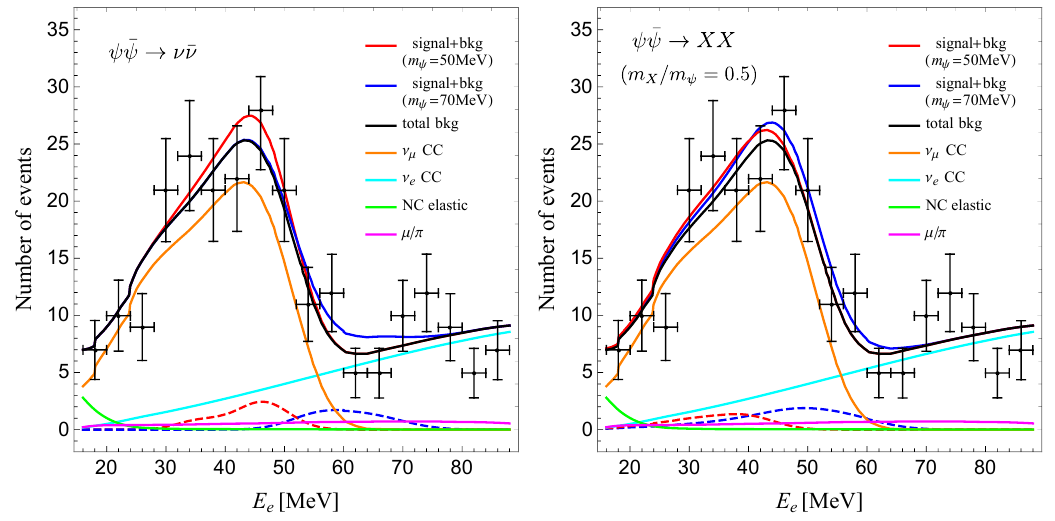
Figure 4 . The DM signal events measured in the SK-I (1,497 days) for (cid:22) ! (cid:23) (cid:22) (cid:23) (left) and for (cid:22) ! XX (right). The cross section is (cid:12)xed such that TS = 2 : 71. Solid (dashed) red and blue curves correspond to the expected signal events with (without) backgrounds. Black points correspond to the observed number of events in the bins with the error bars. The other colored lines correspond to various kinds of background events that are taken from (cid:12)gure 14 of [30].